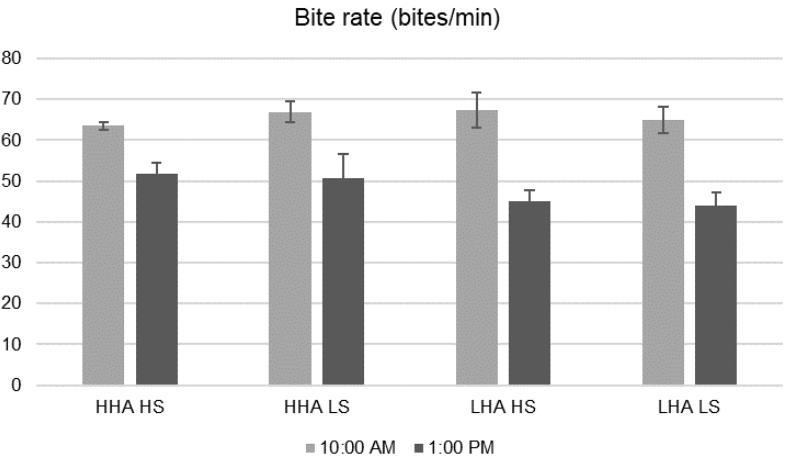
Figure 3. Bite rate of grazing dairy cows during grazing sessions of 270 min. HHA: high herbage allowance (25 kg DM / cow.day). LHA: low herbage allowance (17 kg DM / cow.day). HS: high silage supplementation (9 kg DM / cow.day). LS: low silage supplementation (9 kg DM / cow.day). Vertical bars represent s.e.m. values.